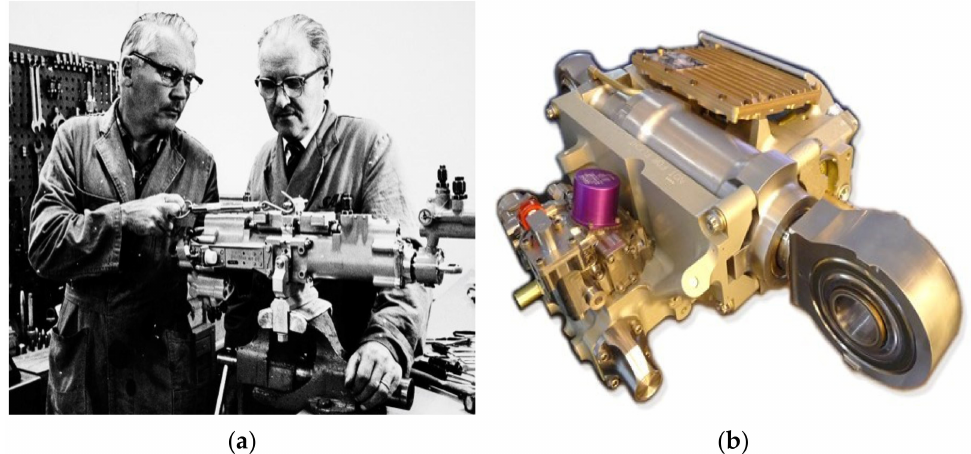
Figure 1. Examples of hydraulically supplied flight control actuators: ( a ) Mechanically-signaled Servodyne hydraulic servoactuator introduced in Sud Aviation Caravelle (Image SAS, Scandinavian Airlines); ( b ) Fly-by-less-wire aileron electro-hydraulic servoactuator, Airbus